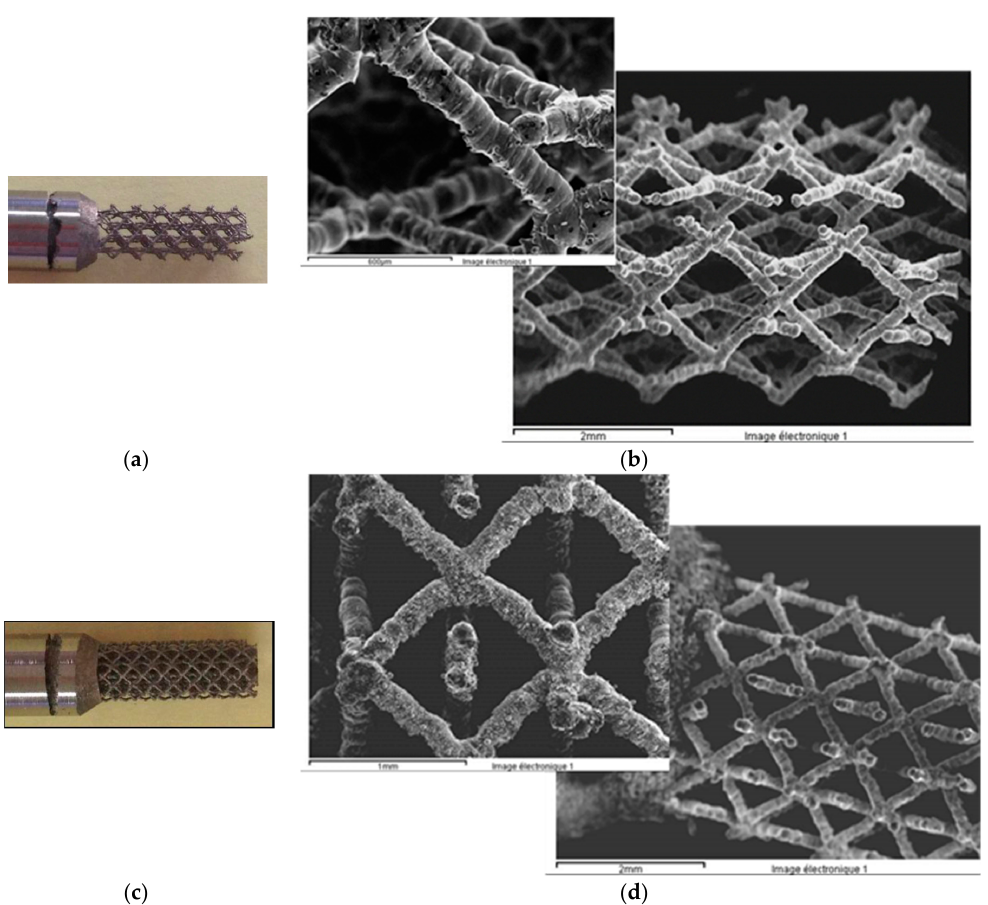
Figure 11. Ti6Al4V alloy scaffold structures with 1000 μ m ( a , b ) and 750 μ m ( c , d )pore size.